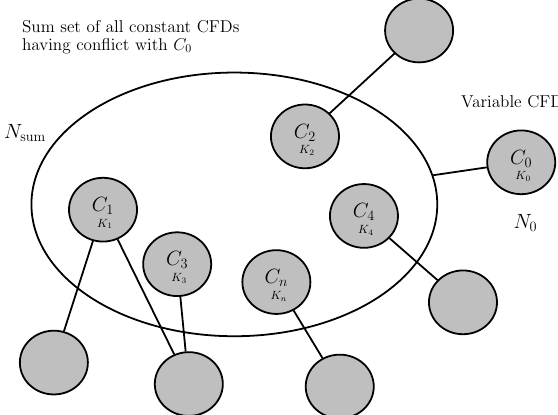
Fig. 4 Put constant CFDs together and leave the variable CFD alone. each vertex as 1. The Maximal Weight Independent